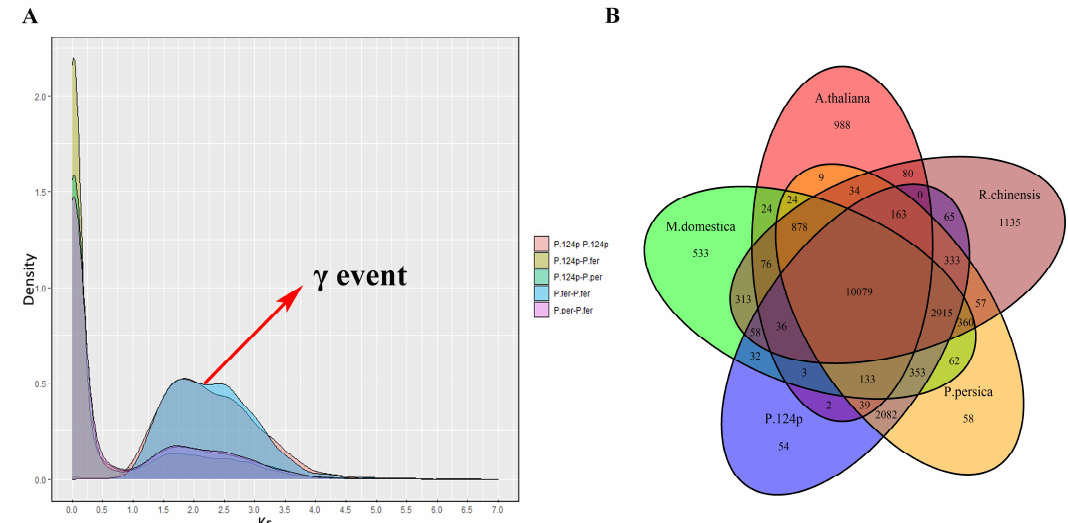
Figure 4. Evolutionary analyses of ‘124 Pan’ genome. ( A ) Distribution of Ks for pairs of paralogs/orthologs in/between ‘124 Pan’, P. persica (Lovell), and P. ferganensis. The eudicot hexaploidization (ancestral γ event) was indicated by red arrow. ( B ) Venn diagram of shared orthologous gene families among ‘124 Pan’ and other four genomes ( A. thaliana , R. chinensis , M. domestica , and P. persica